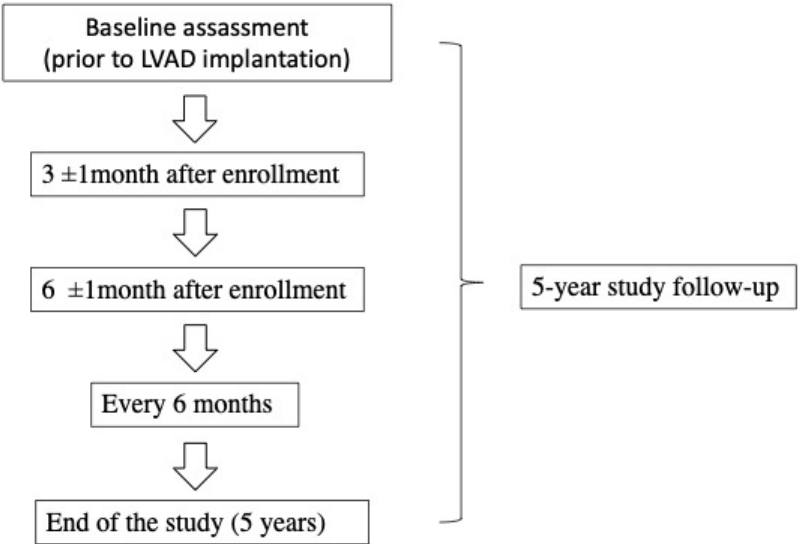
Figure 1. Flowchart of the study. LVAD: Left Ventricular Assist Dev.